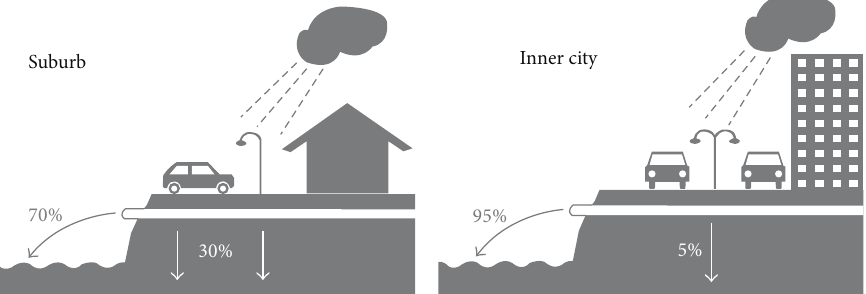
Figure 1: Effect of built areas on the amount of water infiltration (ICPI, 2009).